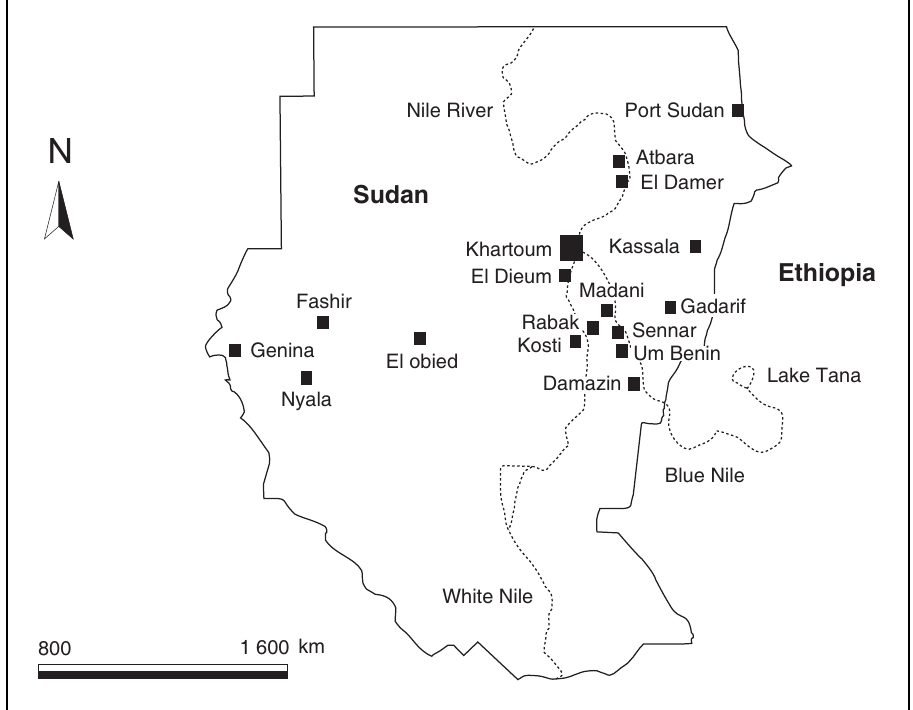
FIG. 1 Map of the Sudan showing localities where samples were